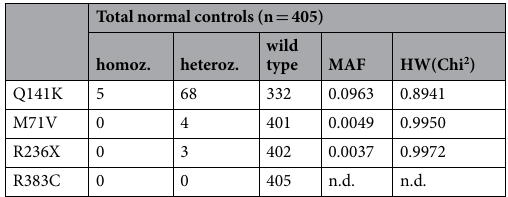
Table 2. The occurrence of the identified mutations and SNPs in the normal, healthy population. MAF (minor allele frequency), and HW (Hardy-Weinberg) equilibrium values were calculated from the merged control group (n = 405) consisting of the healthy volunteer group shown in Fig. 1/Table 1, and a cohort of additional 278 healthy blood donors.